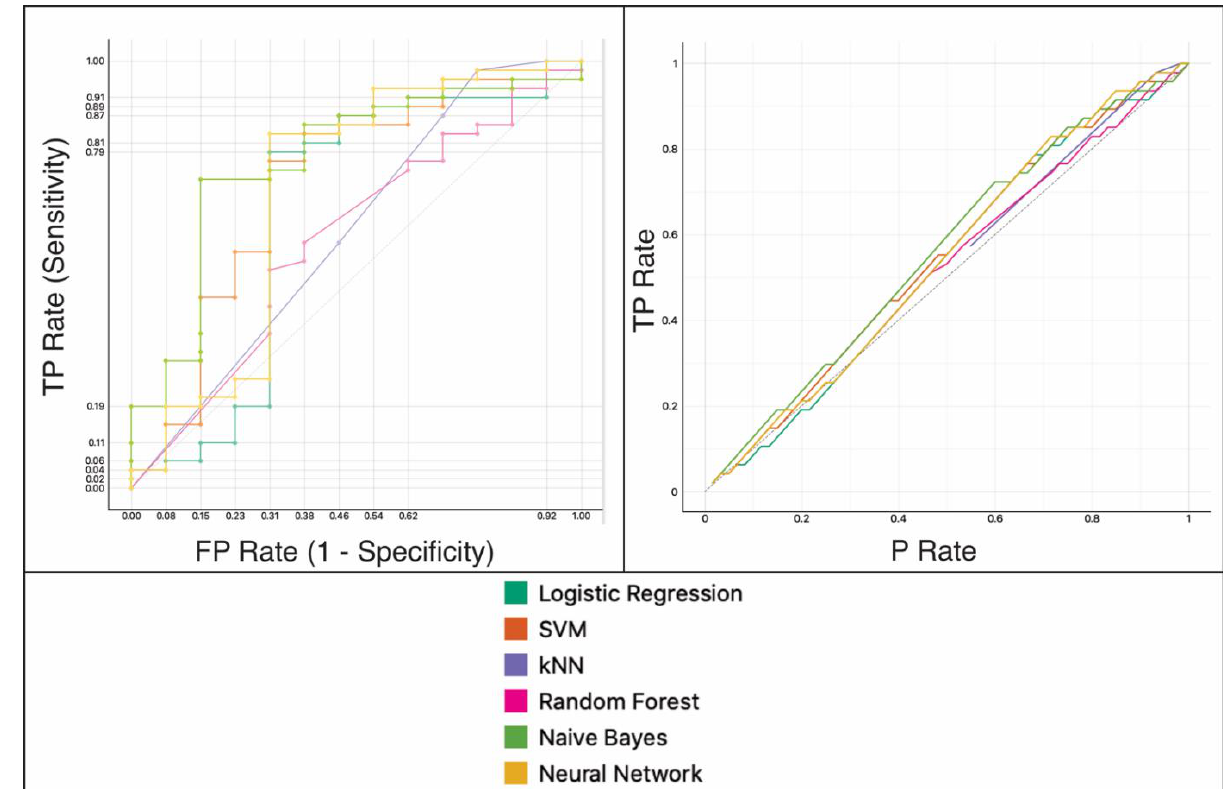
Figure 2. Performance assessment of the binary classification model on the testing data set. left: area under the receiver operating characteristic (ROC) curve and right: calibration plot. kNN = k-nearest neighbor, SVM = support vector machine, TP = true positives, FP = false positives, P = positives.